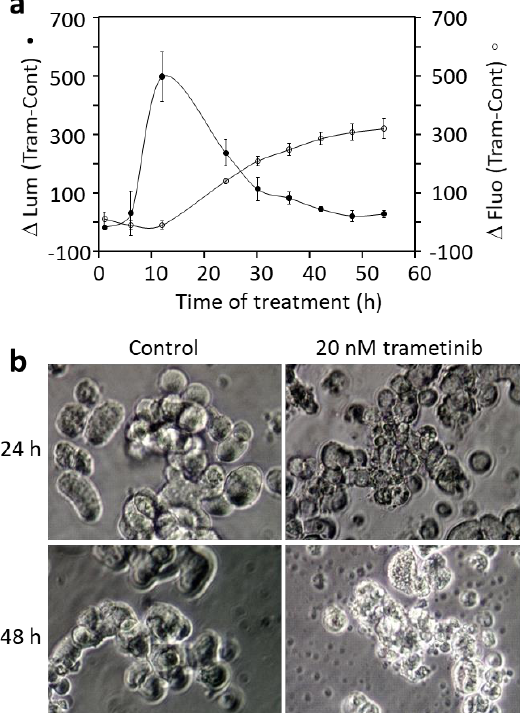
Figure 4. Effects of trametinib on DU-4475 cells. ( a ) Detection of apoptosis and necrosis in DU-4475 cells treated with 20 nM trametinib. DU-4475 cells were treated with 20 nM trametinib and